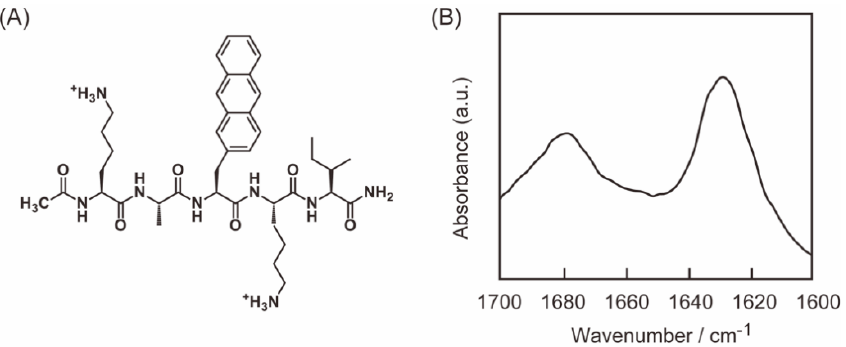
Figure 4. ( A ) Molecular structure of RU065 4–8 ( j ), a peptide fragment with the potential to selectively recover Au from mixtures of Au and Pt ions. ( B ) ATR-FTIR spectrum of RU065 4–8 ( j ) peptide